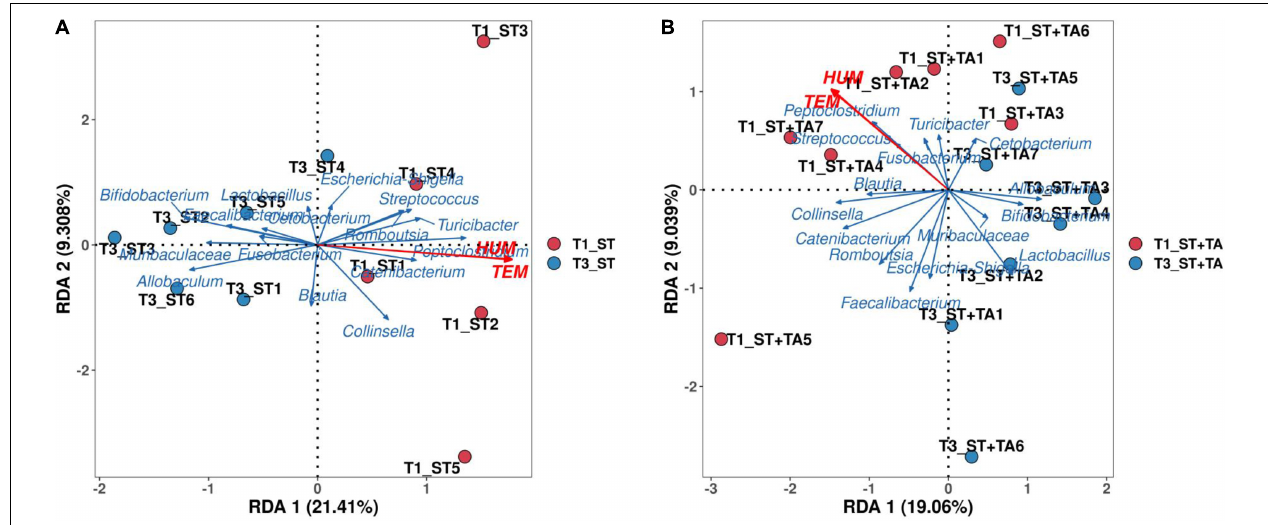
FIGURE 5 | Redundancy analysis (RDA) of environmental factors and the microbial community at T1 and T3. RDA in the ST group at T1 and T3 (A) , RDA in the ST + TA group at T1 and T3 (B) . T1, day 7 before transportation; T3, day 14 after transportation.